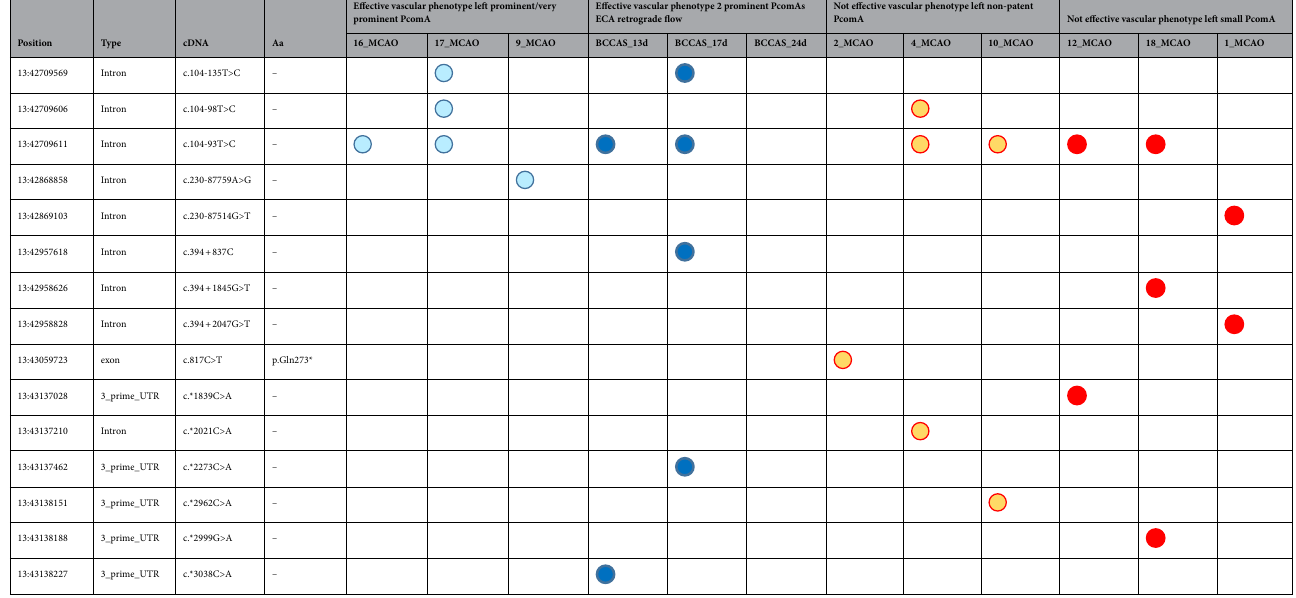
Table 4. Phactr1 coding and non-coding variants detected in MCAO and BCCAS mice with exome